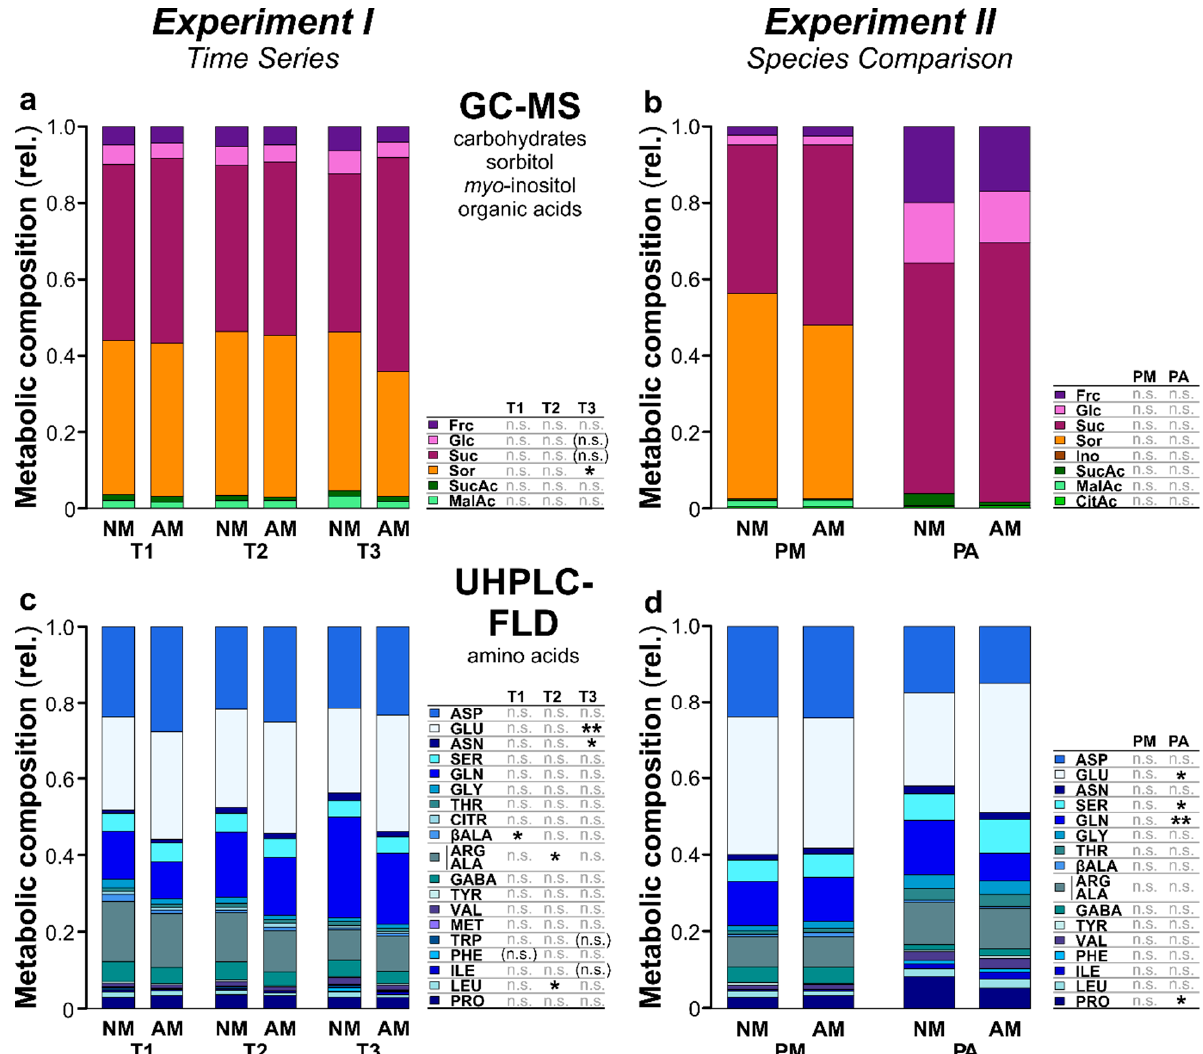
the metabolites are given in Table 1. The sample sizes (biological replicates) were: n = 11–12 ( Experiment I ), n = 9–12 ( Ex- periment II ).